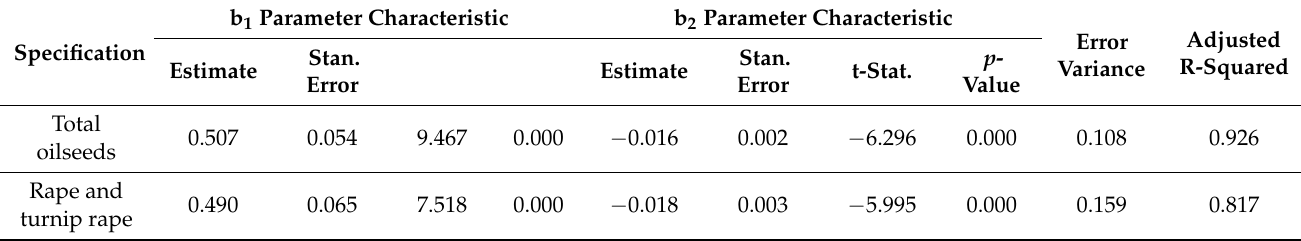
Adjusted Error p - Stan. Variance t-Stat. Estimate Value Error